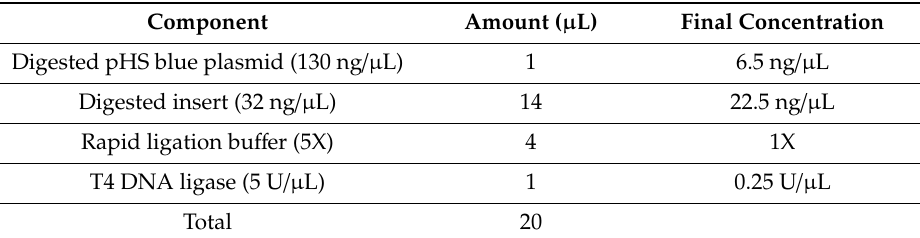
Table 5. Reaction mixture for the ligation of pHS blue and the insert.